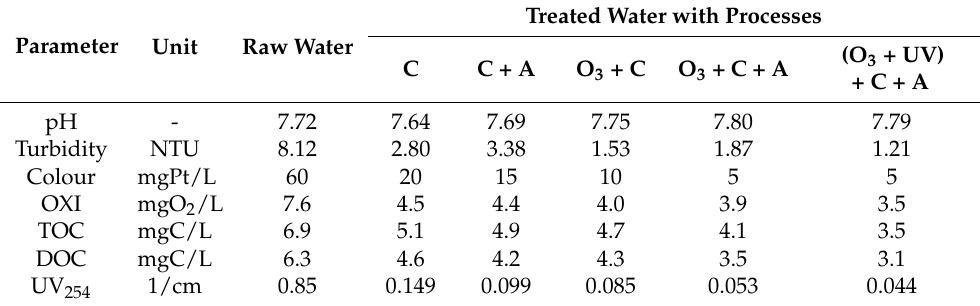
Table 8. Values of selected parameters of raw natural water and treated water in the coagulation process and hybrid